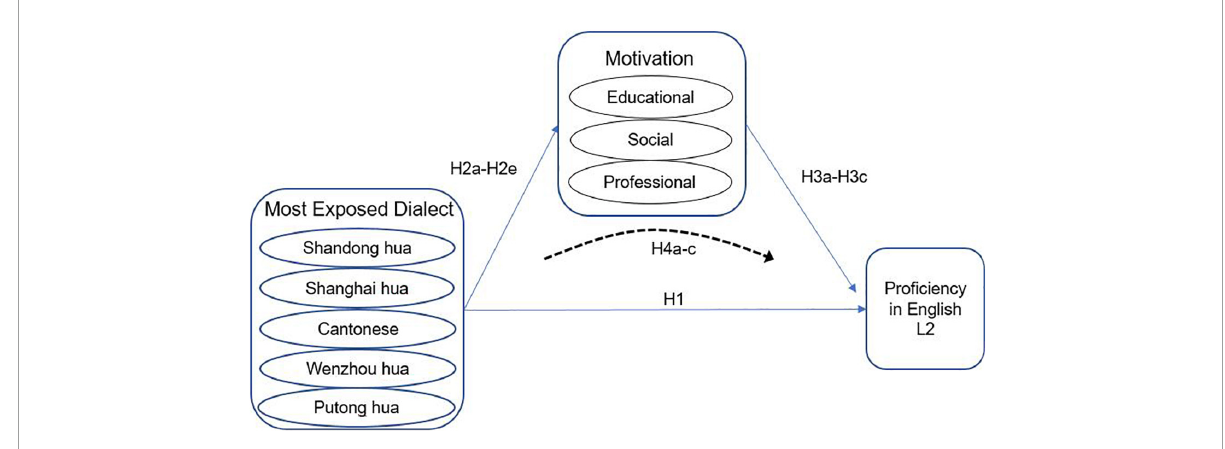
FIGURE2 Theoretical framework.